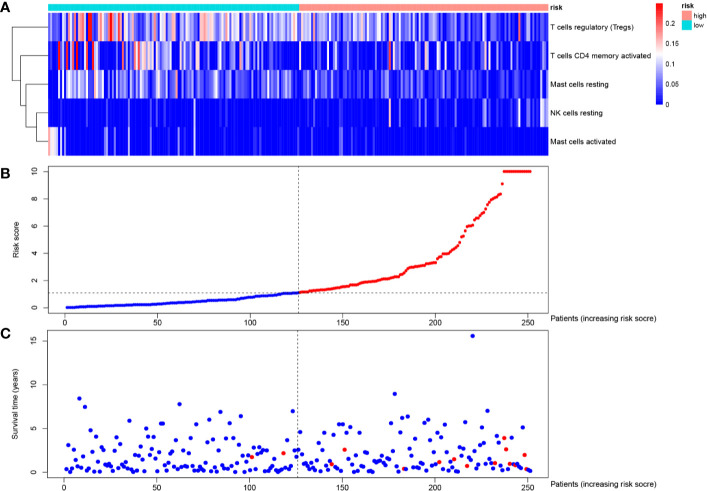
Risk curve of the Cox regression model. Distribution of (A) risk score, (B) survival statuses and (C) expression profile of prognostic tumor-infiltrating immune cells of each patient.